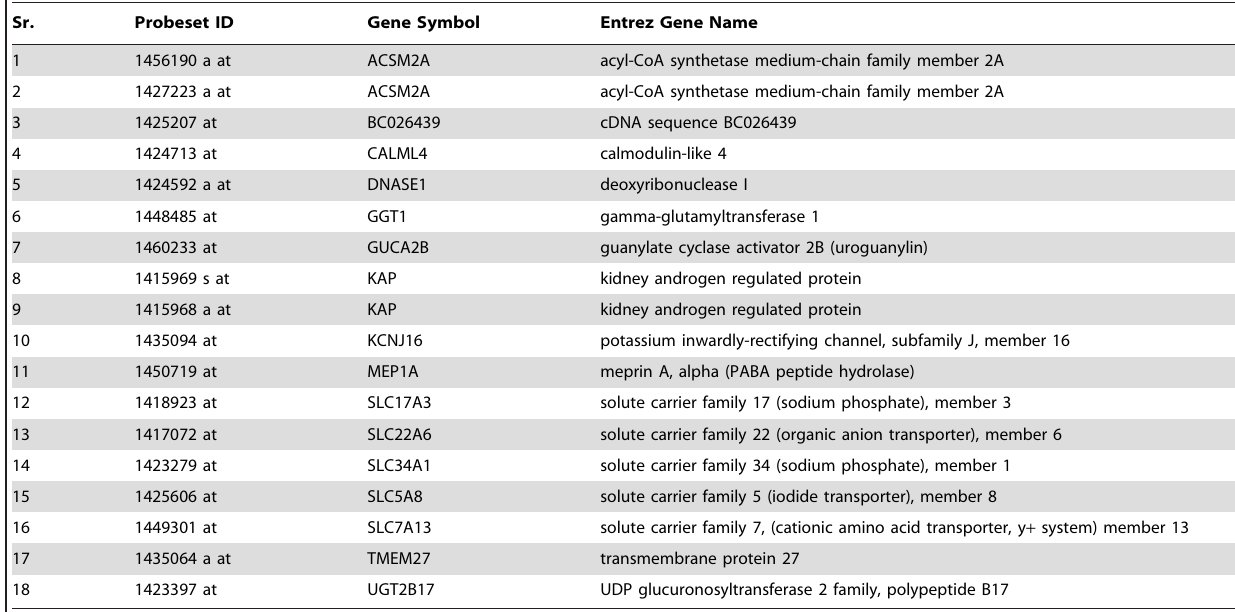
Table 17. Kidney Sr.